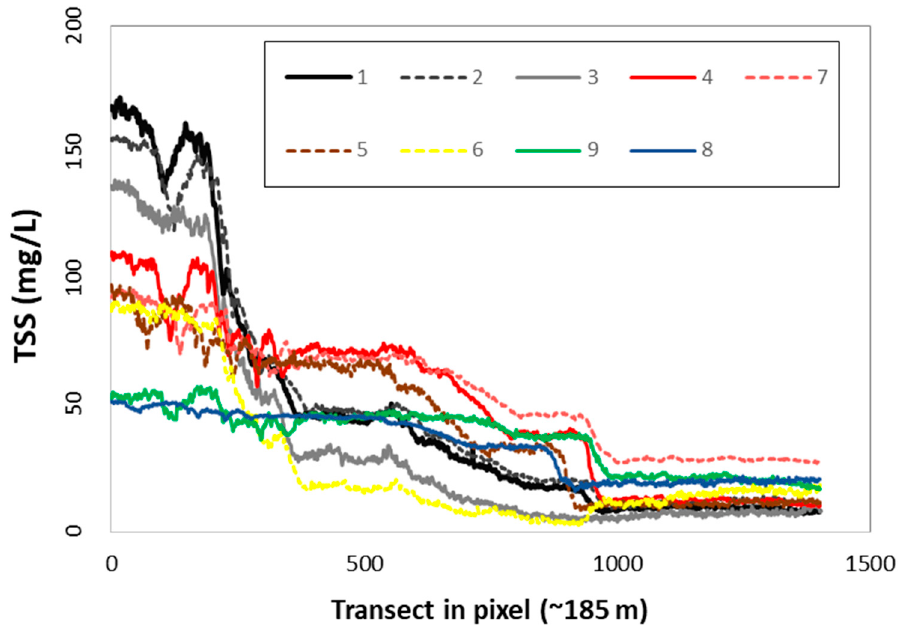
Figure 11. Estimated TSS values using different retrieval models along an arbitrary transect on 2018/10/31 in the Paranoá reservoir. Model are identified by their number (see Table 3).